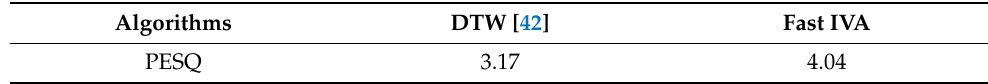
Table 4. PESQ averages with different